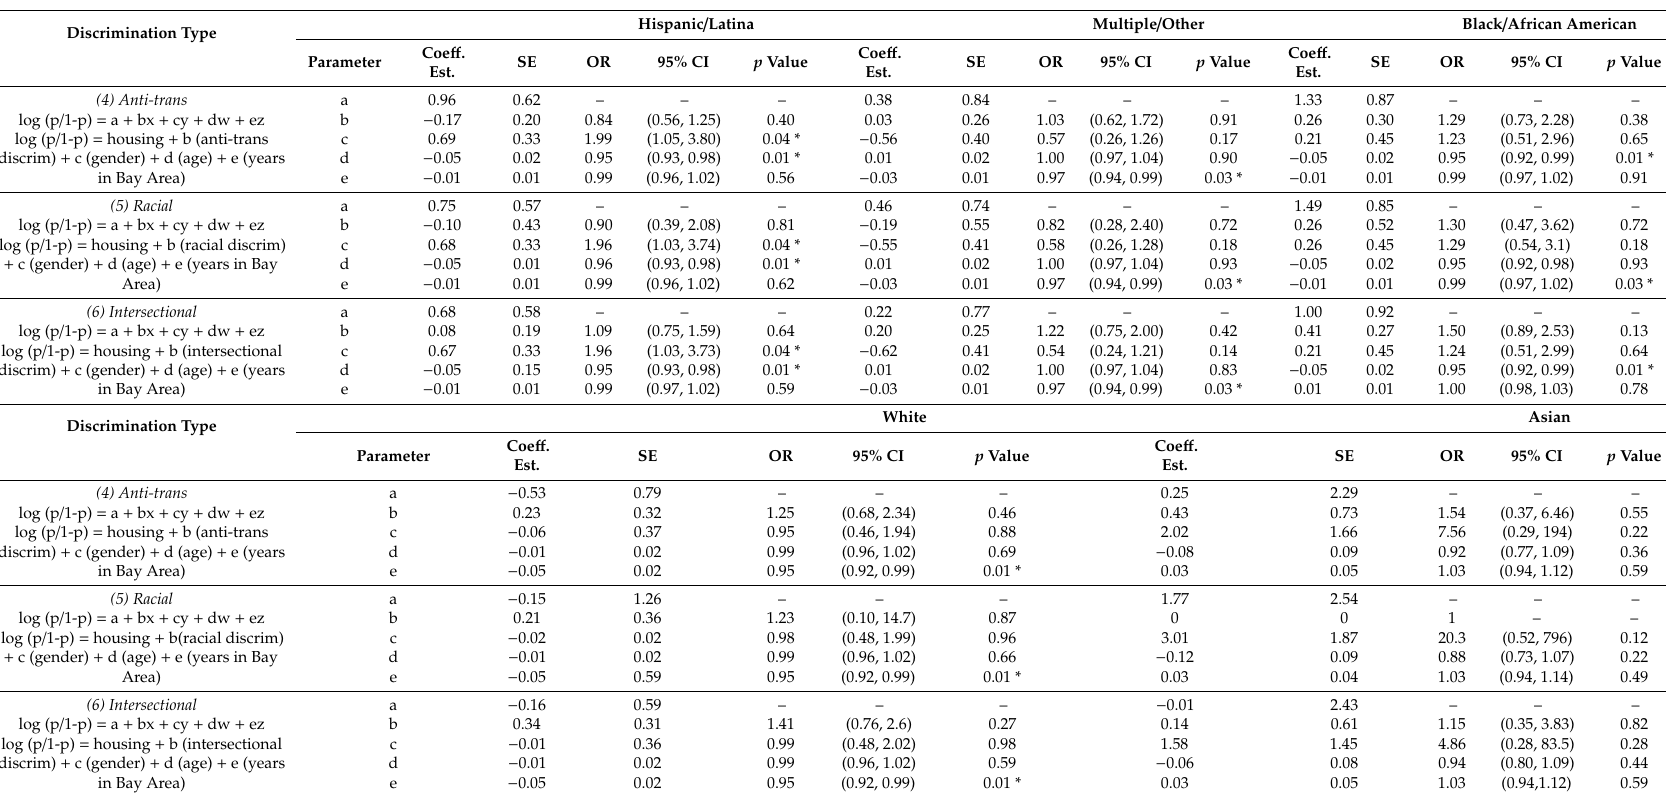
Table 3. Stratifying by race / ethnicity, the odds of housing instability associated with exposure to anti-trans, racial, or intersectional discrimination among trans women in the San Francisco Bay Area, adjusting for gender identity, age, and years lived in the Bay Area. / Latina Multiple / Other Black / African Discrimination Type Hispanic